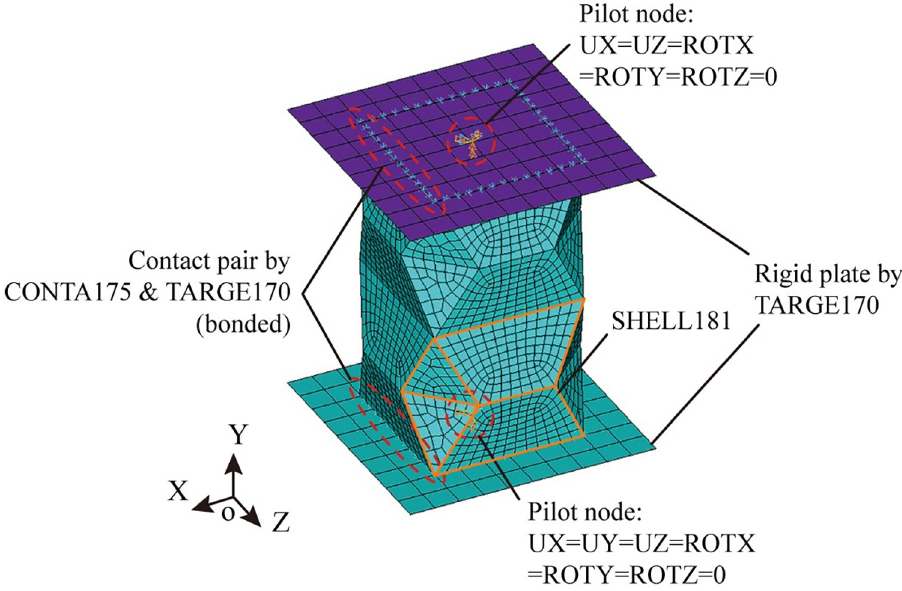
Fig 5. Finite element modelling of crash